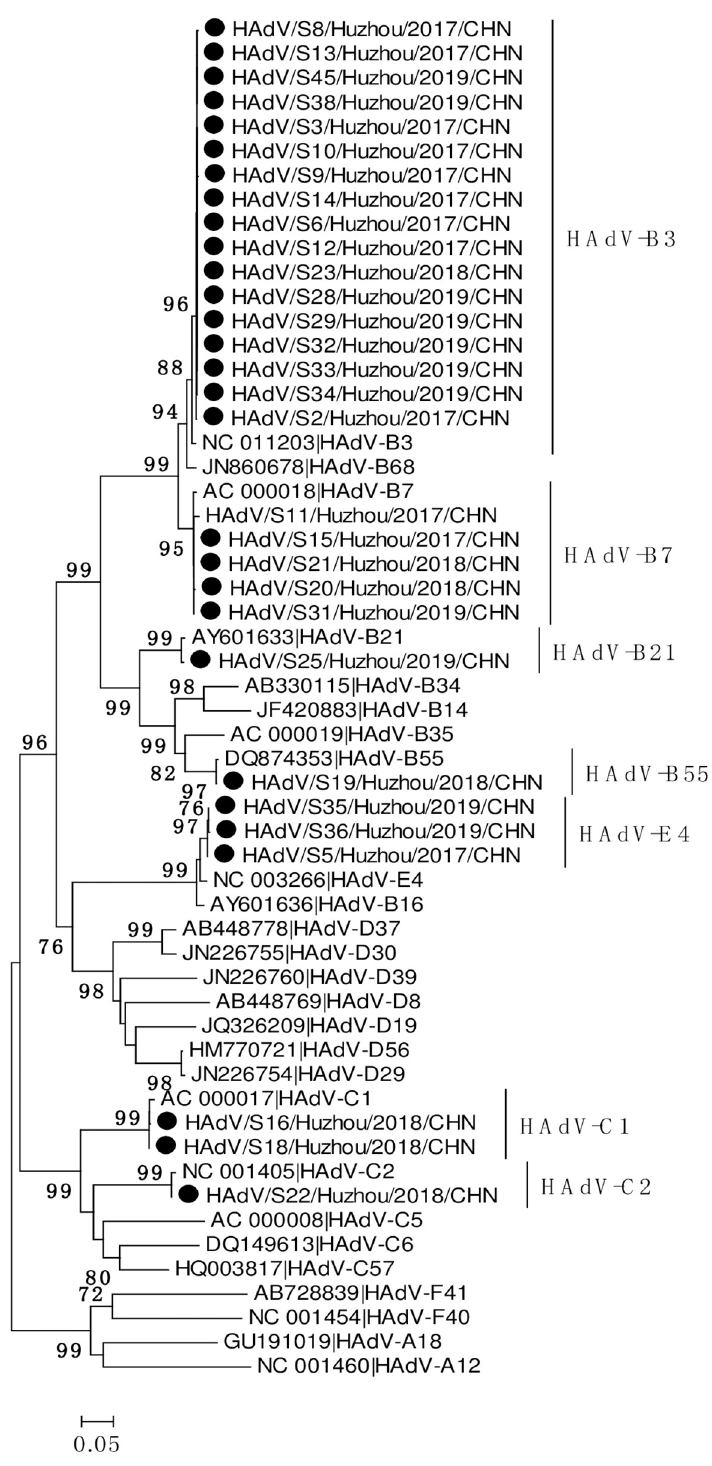
Fig 2. Phylogenetic analyses based on partial hexon sequences of HAdV strains. The trees were generated using the neighbor-joining method, validated by 1000 bootstrap replicates. Bootstrap values � 70% are shown on the branch. HAdV sequences identified in this study are indicated by closed